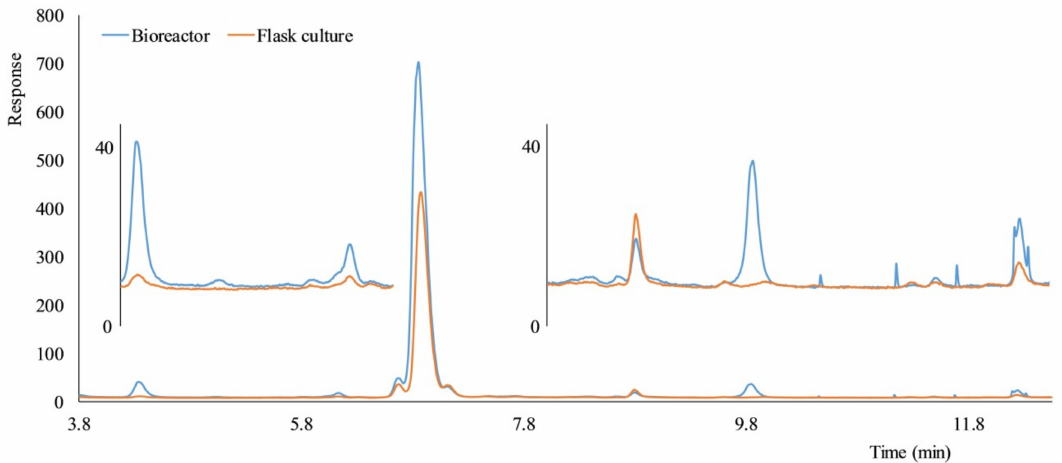
Figure 8. Comparison of HPLC-ELSD chromatograms of hairy roots exudates of Sesamum indicum (accession Japan) grown in the bioreactor and a flask culture. Culture fluid clarified by centrifugation was directly analyzed by